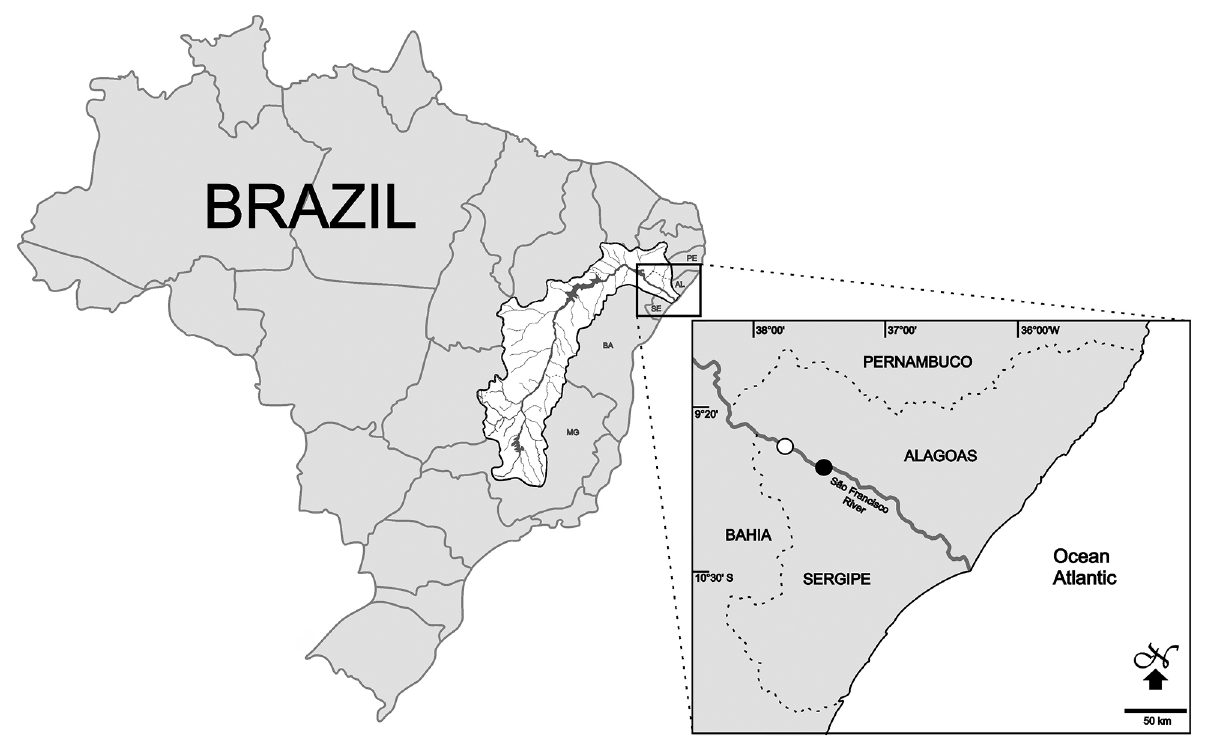
Figure 2. Map of Brazil indicating the São Francisco River watershed. Inset: sampling site (black circle) and the region of the Xingó Reservoirs (white circle). Legend: MG–Minas Gerais; BA–Bahia; SE–Sergipe; AL–Alagoas;